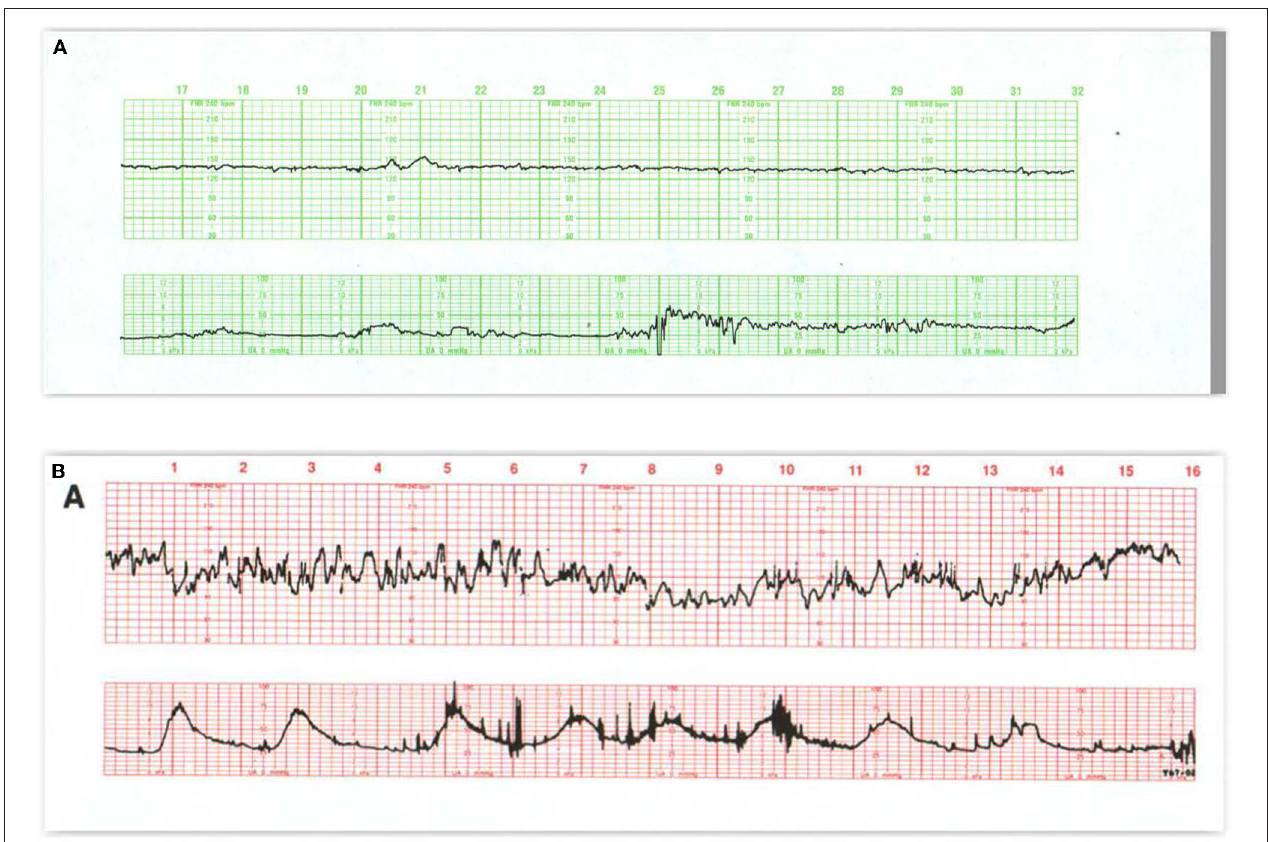
FIGURE 3 | (A) This tracing, obtained in early labor, reflects several effects of medication on the FHR pattern and uterine contractions. Narcotics decrease baseline variability as well as the frequency and angularity of the accelerations associated with fetal movement. Notice that the accelerations appear only with contractions, if at all, and that the accelerations arise from diminished variability. In (B) contractions are frequent, variability is exaggerated (saltatory), and decelerations are absent. The fetus responds to the excessive uterine activity between 5M and 10M with an erratic but prolonged deceleration. As the contractions space out, the fetal heart rate begins to return and then exceed the previous baseline for a brief period which is proportional to the duration of the fetal hypoxemia. Often the fetus exhibits one or more late decelerations during the recovery (at 12M). The nadir of the deceleration never goes below 90 bpm and the fetus retains considerable variability during the deceleration. Clinical management should include cessation of oxytocin, repositioning to the left side, and, if necessary, administration of tocolytics to effectively diminish the uterine activity and promote optimum maternal-fetal circulatory exchange. Scaling − 30 bpm/cm—vertical, 3 cm/min—horizontal—each panel is 16min